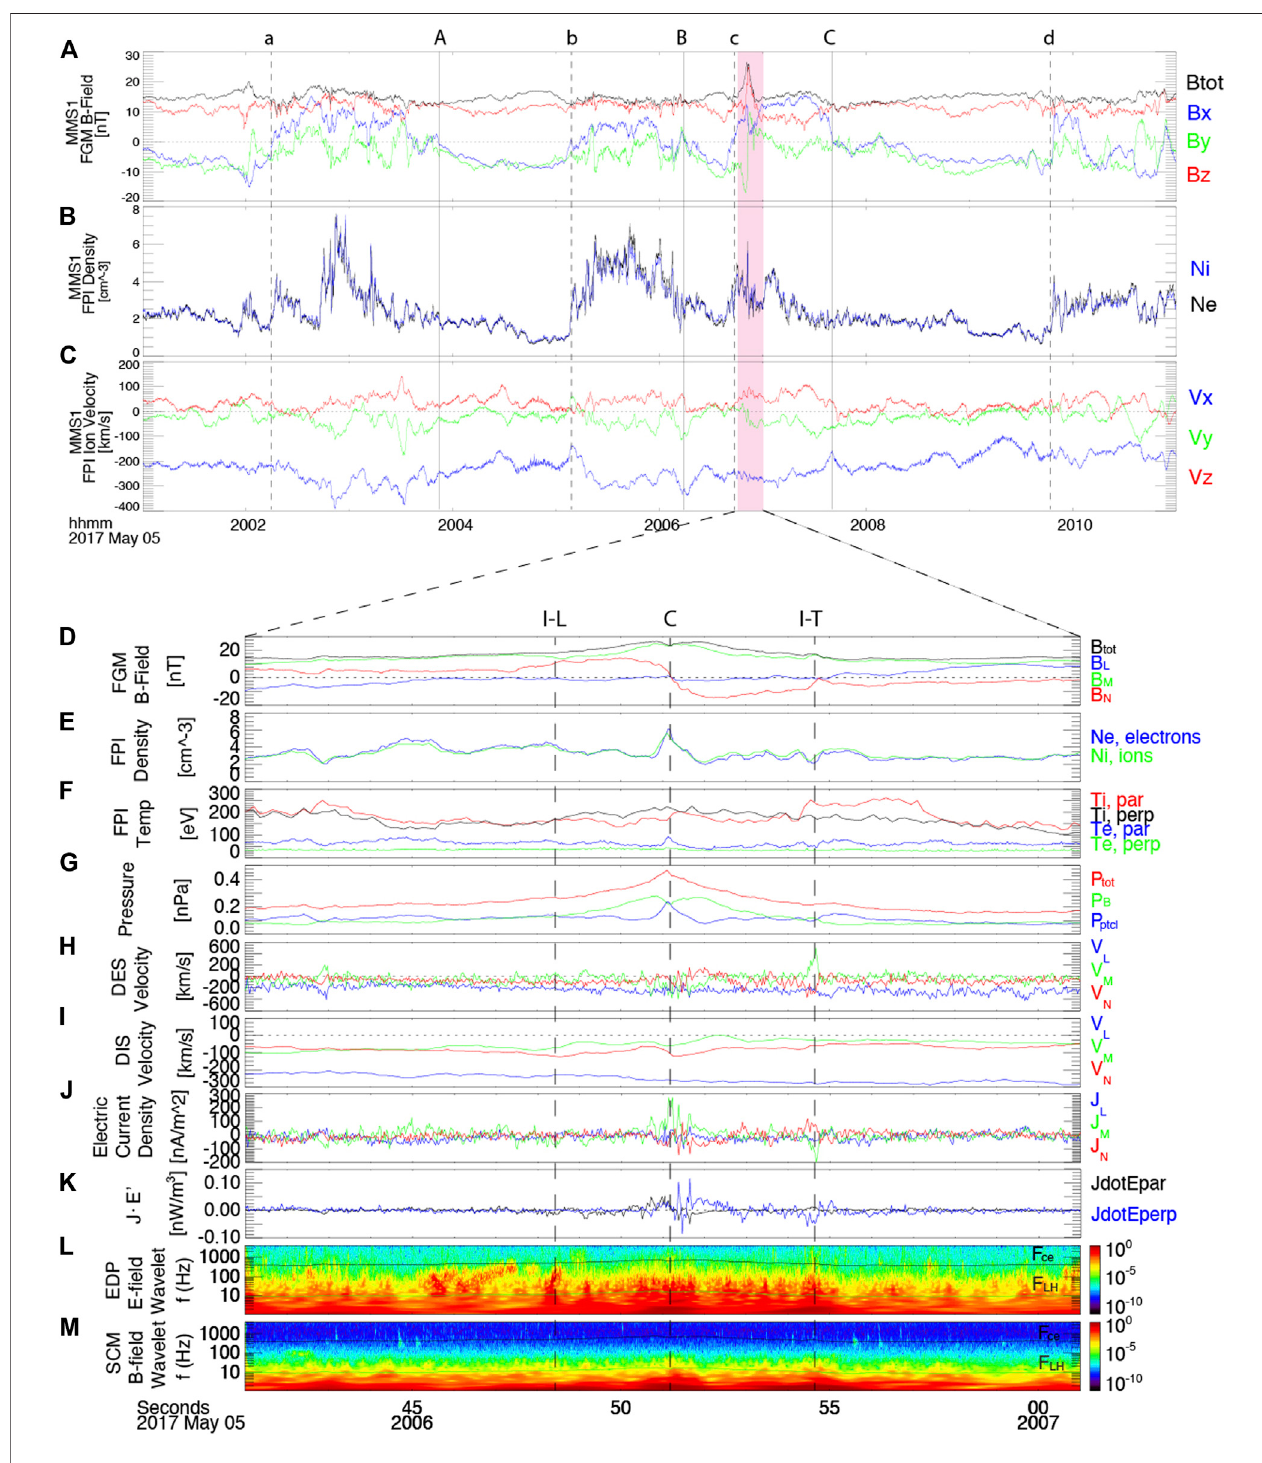
FIGURE1|(A – C) OverviewofMMS1observation ofMay5.2017event. (A) Magnetic fi eld, (B) particle density,and (C) ionvelocityintheGSMcoordinate.Vertical dashed lines (A – D) correspond to trailing edges of nonlinear developed K-H waves, and solid vertical lines (A – C) correspond to leading edges. (D – M) Enlarged plots showing the crater fl ux rope in LMN coordinate. (D) Magnetic fi eld, (E) density, (F) temperature, (G) pressure, (H) electron velocity, (I) ion velocity, (J) electric current density, (K) energy dissipation proxy J · E ′ , (L) electric fi eld power spectrogram, and (M) magnetic fi eld power spectrogram.